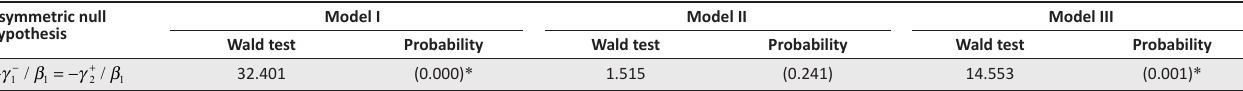
TABLE 8: Long-run asymmetric